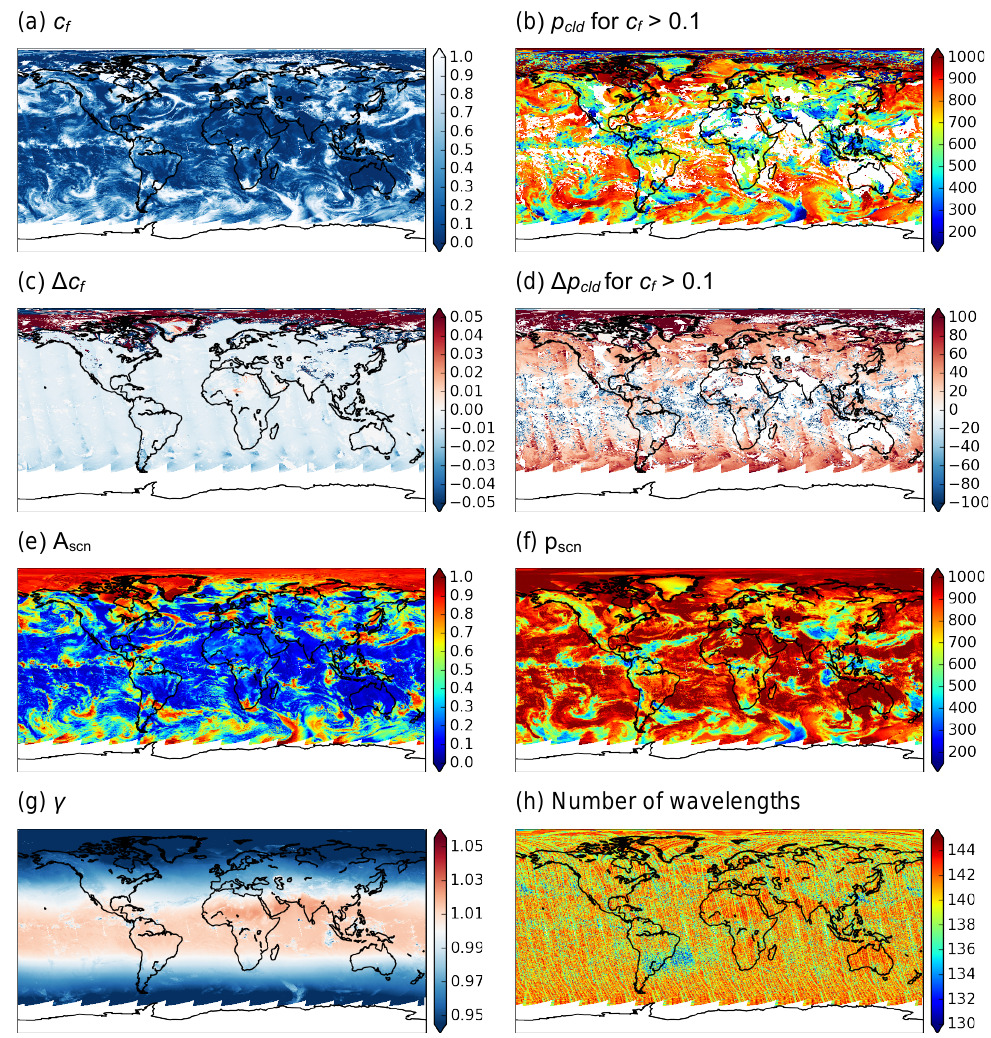
Figure 4. Results from the OMCLDO2 version 2 algorithm for 14 May 2005. (a) Effective cloud fraction, (b) effective cloud pressure, (c) difference of the effective cloud fraction (version 1.2.3 minus version 2), (d) difference of the effective cloud pressure (version 1.2.3 minus version 2), (e) scene albedo, (f) scene pressure, (g) temperature correction factor γ and (h) number of wavelengths used in the DOAS Figure 4: Results from the OMCLDO2 version 2 algorithm for 14 May 2005. a) effective cloud fraction, b) 674 effective cloud pressure, c) difference of the effective cloud fraction (version 1.2.3 minus version 2), d) 675 difference of the effective cloud pressure (version 1.2.3 minus version 2), e) scene albedo, f) scene pressure, g) 676 temperature correction factor γ , and h) number of wavelengths used in the DOAS fit. 677